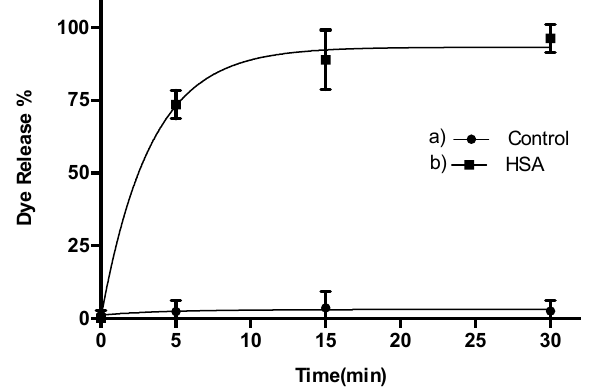
Figure 2. Release of rhodamine B versus time from PBS (pH 7.4)-acetonitrile 95:5 v / v suspensions of S1 nanoparticles (a) in the absence and (b) in the presence of HSA (1000 μg mL −1 ) at 25 °C (100% is the maximum of rhodamine B released from S1 solid).